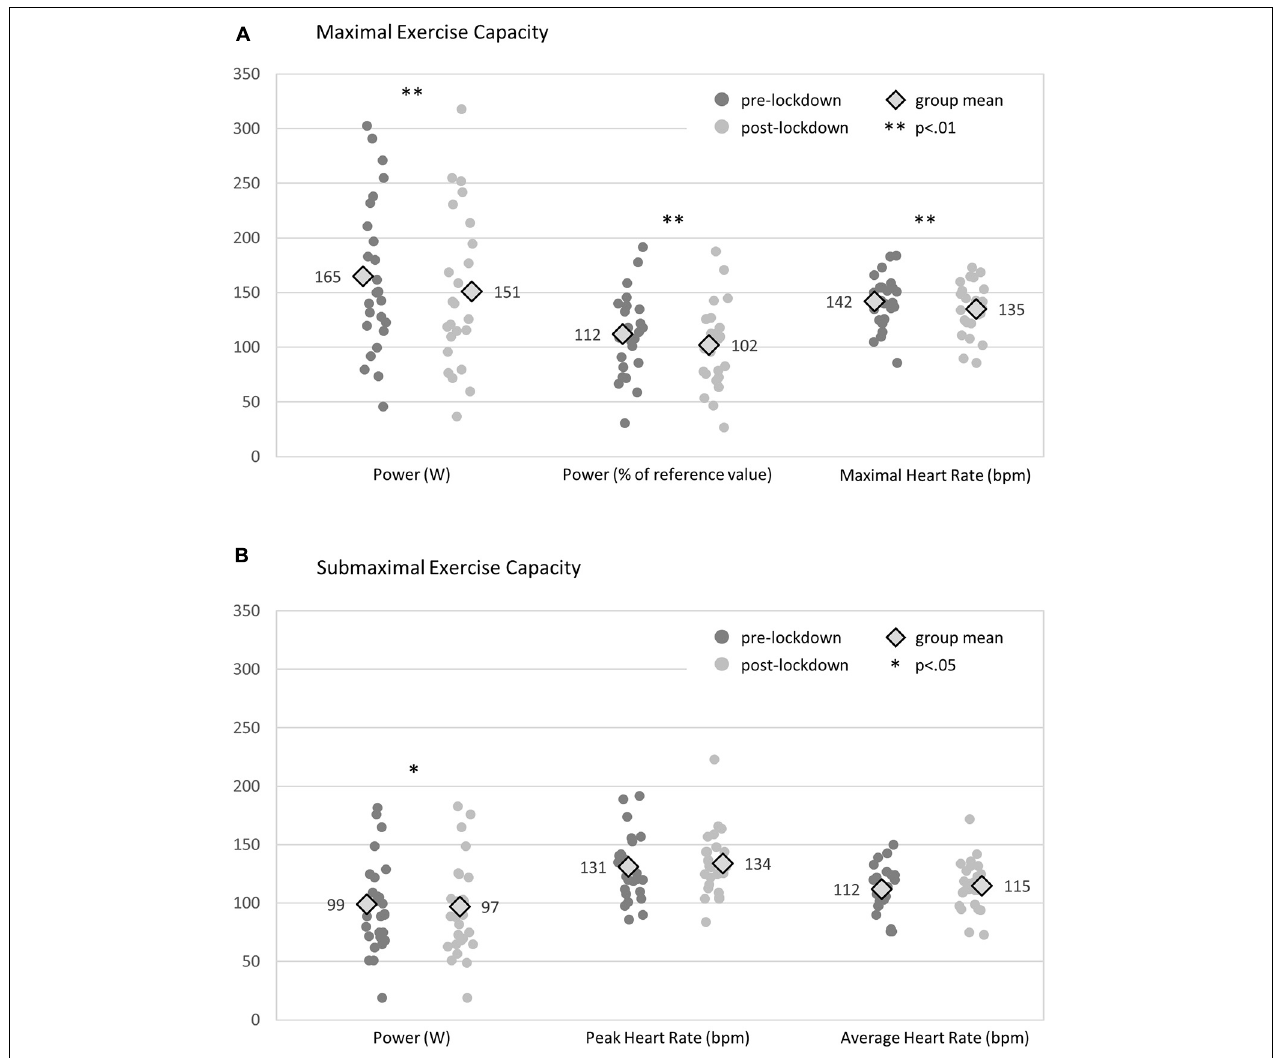
FIGURE 2 | Change in maximal (A) and submaximal (B) exercise